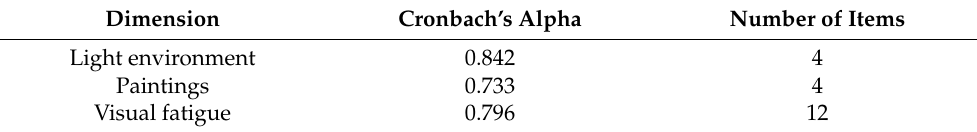
Table 6. Reliability analysis.